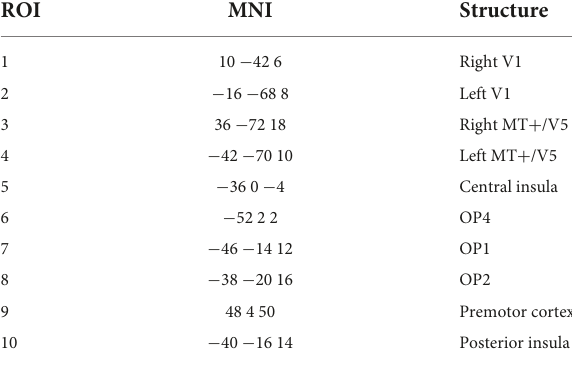
TABLE 1 Region of interest